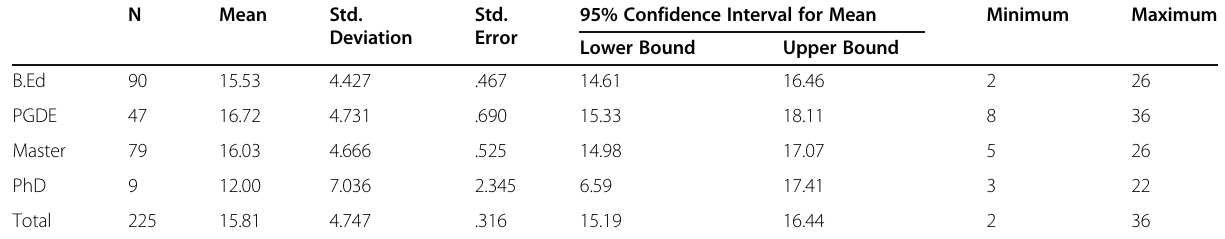
Table 9 Mean Score of Bhutanese Science Teachers ’ Perceptions of the NOS Based on Qualification N Mean Std. Std. Deviation